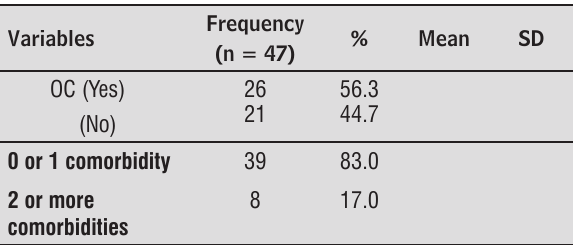
Table 1 - Sociodemographic characteristics, pathologies related to the development of CKD and comor-